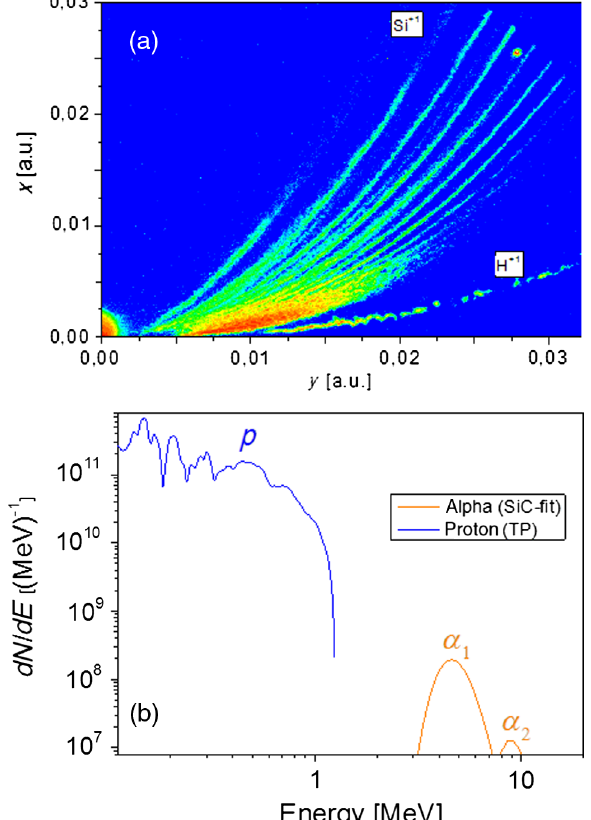
FIG. 7. (a) Typical TP spectrometer snapshot showing the presence of backward-accelerated protons and heavier plasma ions (a). The corresponding proton-energy distribution and the comparison with the alpha-particle one (obtained by fitting the TOF spectrum in Fig. 6) are shown in